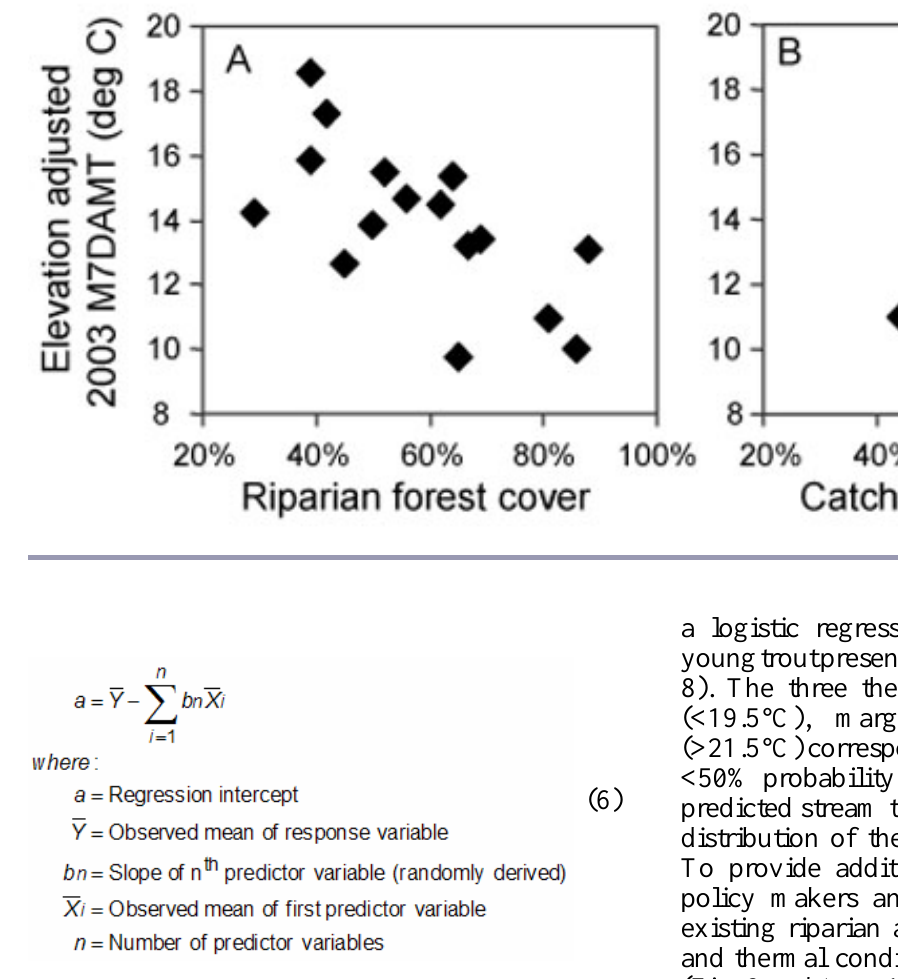
Fig. 9. Elevation-adjusted M7DAM temperatures related to percent riparian and catchment forest cover values. A significant relationship was detected between these stream temperatures and percent riparian forest cover (r 2 = 0.38; p = 0.01) but not percent catchment forest cover ( p =